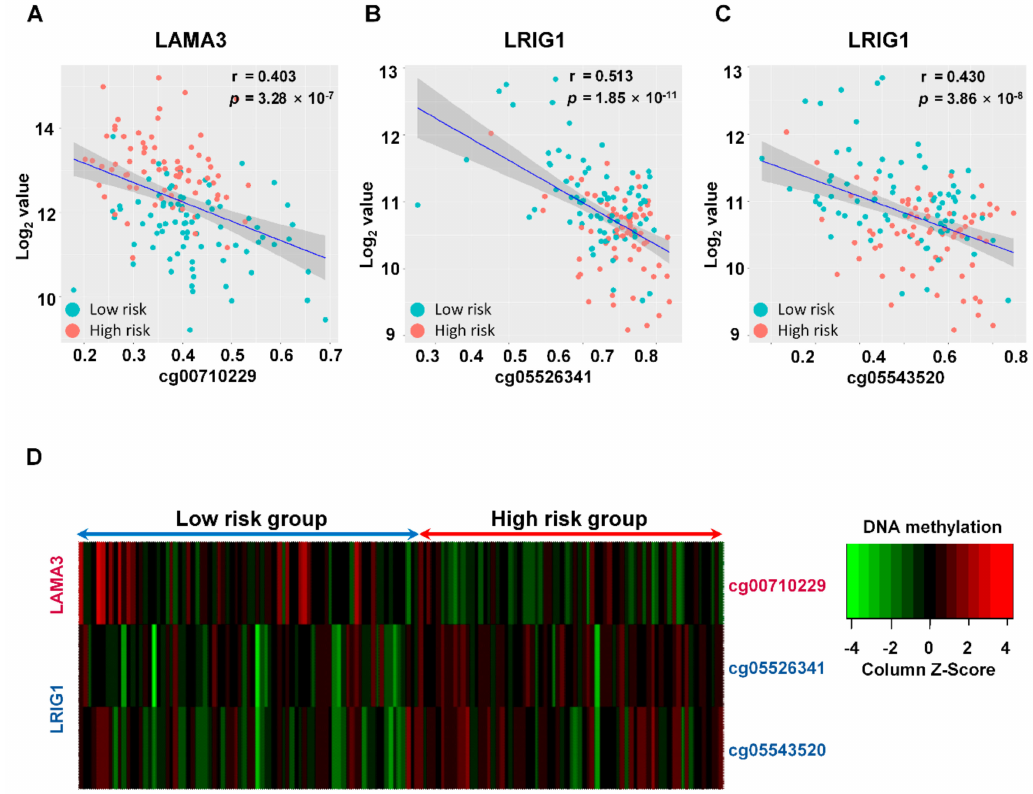
Figure 9. Methylation assessment of LAMA3 and LRIG1 genes in two risk-subgroups according to PAC-5 signature. Pearson’s correlation was used to measure linear relationships between DNA methylation and gene expression levels. r -Value indicated the Pearson’s correlation coe ffi cient, and the p -Value (2-tailed) was the probability of a correlation. ( A – C ) Correlations between DNA methylations and the indicated genes. ( D ) Heatmap showed trend of the PAC-5 gene methylations according to the risk-subgroups. The colour keys of standardised methylation β values were presented in the legends, with red indicating hypermethylation and green indicating